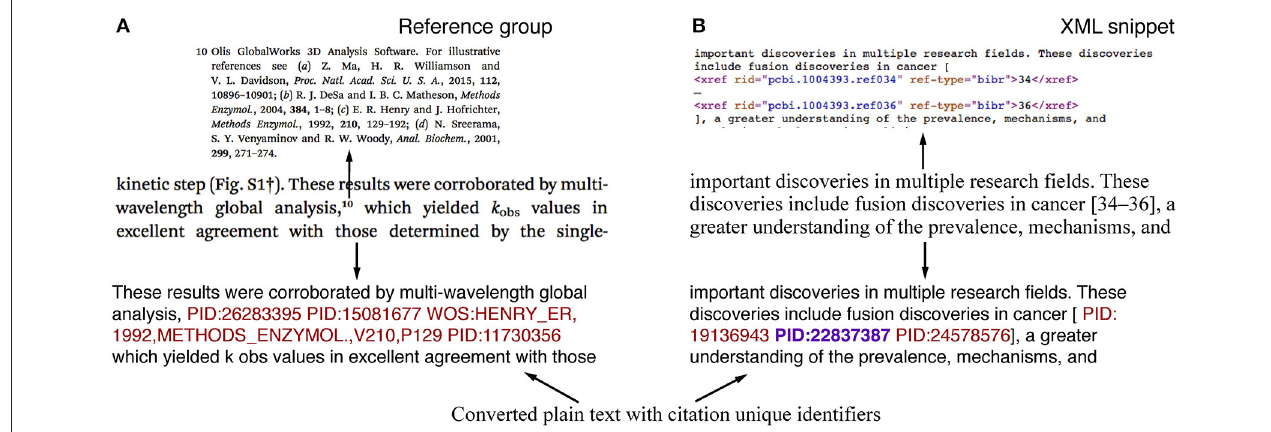
FIGURE 3 | Two examples of converting XML into plain